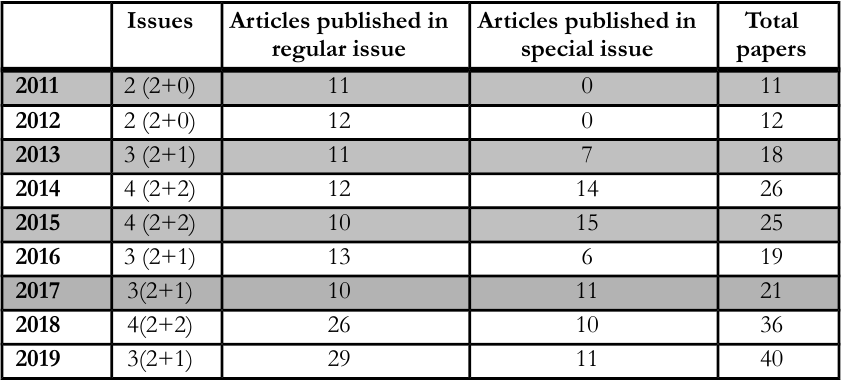
Table 2. Articles published evolution from 2010 to